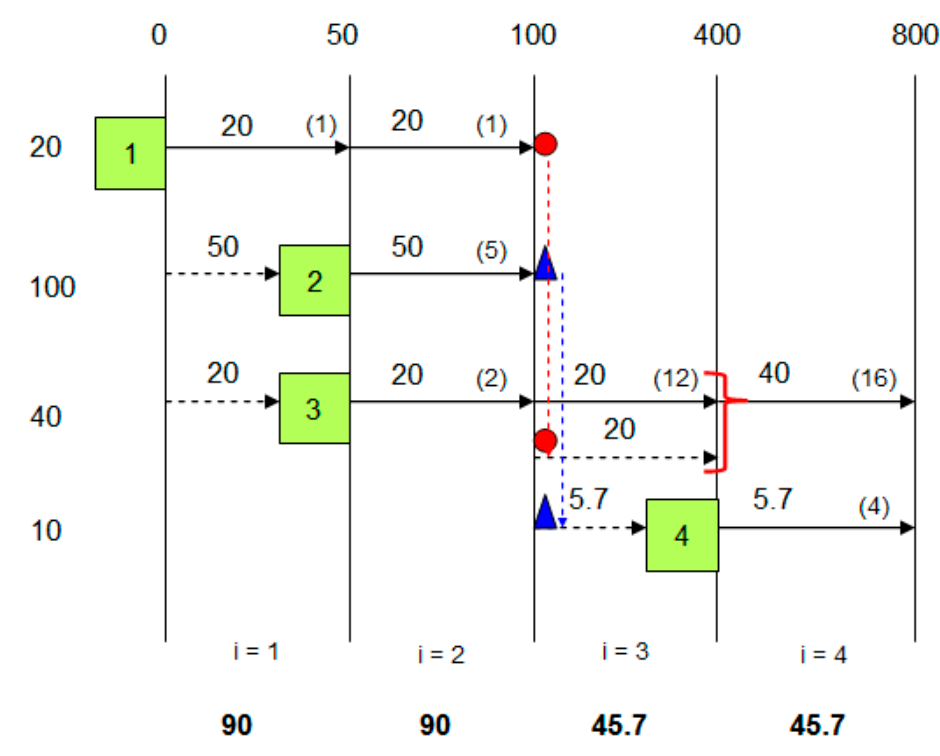
Figure 2. Final WSD representation.